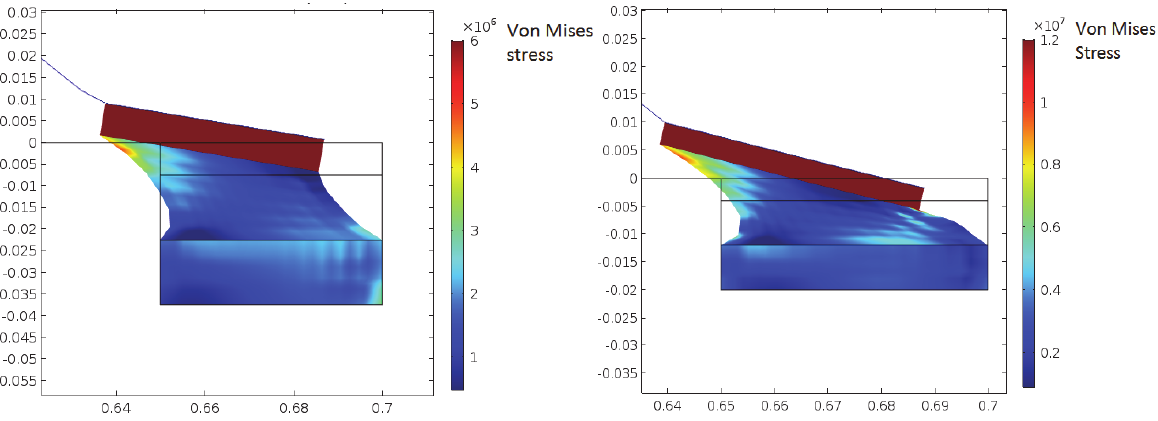
Fig. 15: Von Mises stress distribution in a joint of same bite of 50mm and a joint thickness of respectively a) 15 mm and b)